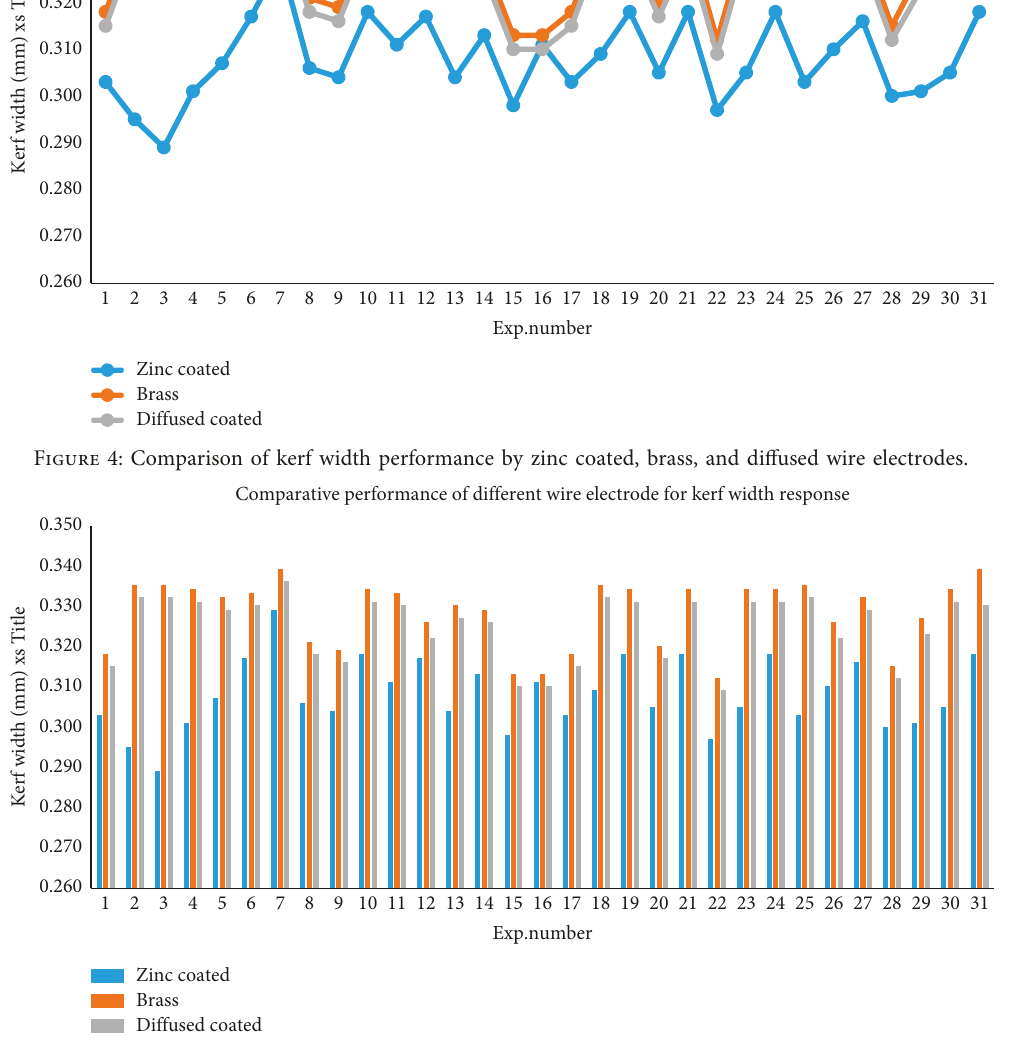
Figure 5: Comparison of kerf width for zinc coated, brass, and diffused wire electrodes.